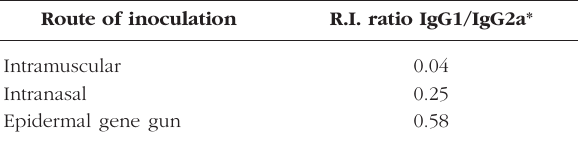
Table I. – AgB-specific IgG1/IgG2a reactivity index (R.I.) ratios in mice immunized with EgAgB8/2-DNA using different routes of ino - culations. Serum samples were collected 50 days following initial inoculations and were assayed for AgB-specific IgG1 and IgG2a.